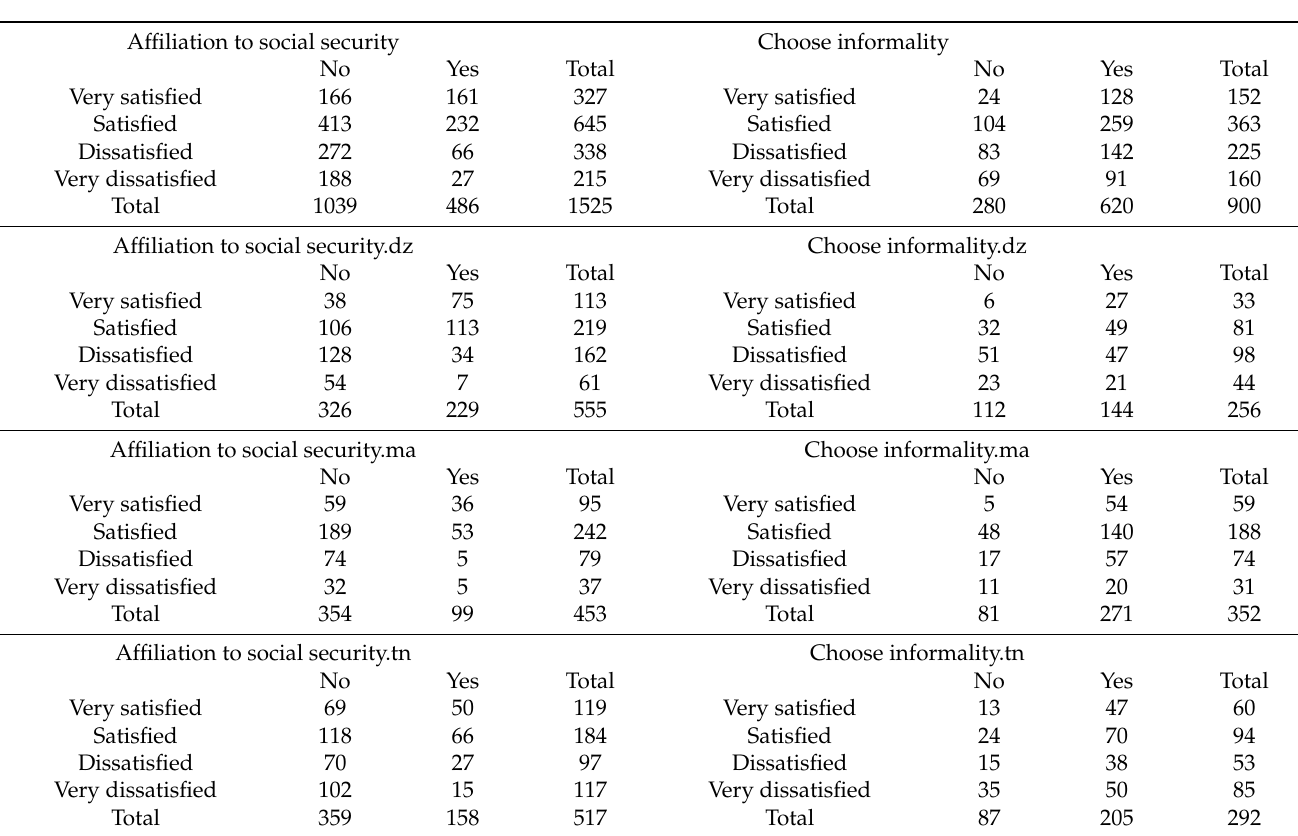
Table A7. Affiliation to social security and the reason for not being insured according to job satisfaction. Source: Sahwa dataset.